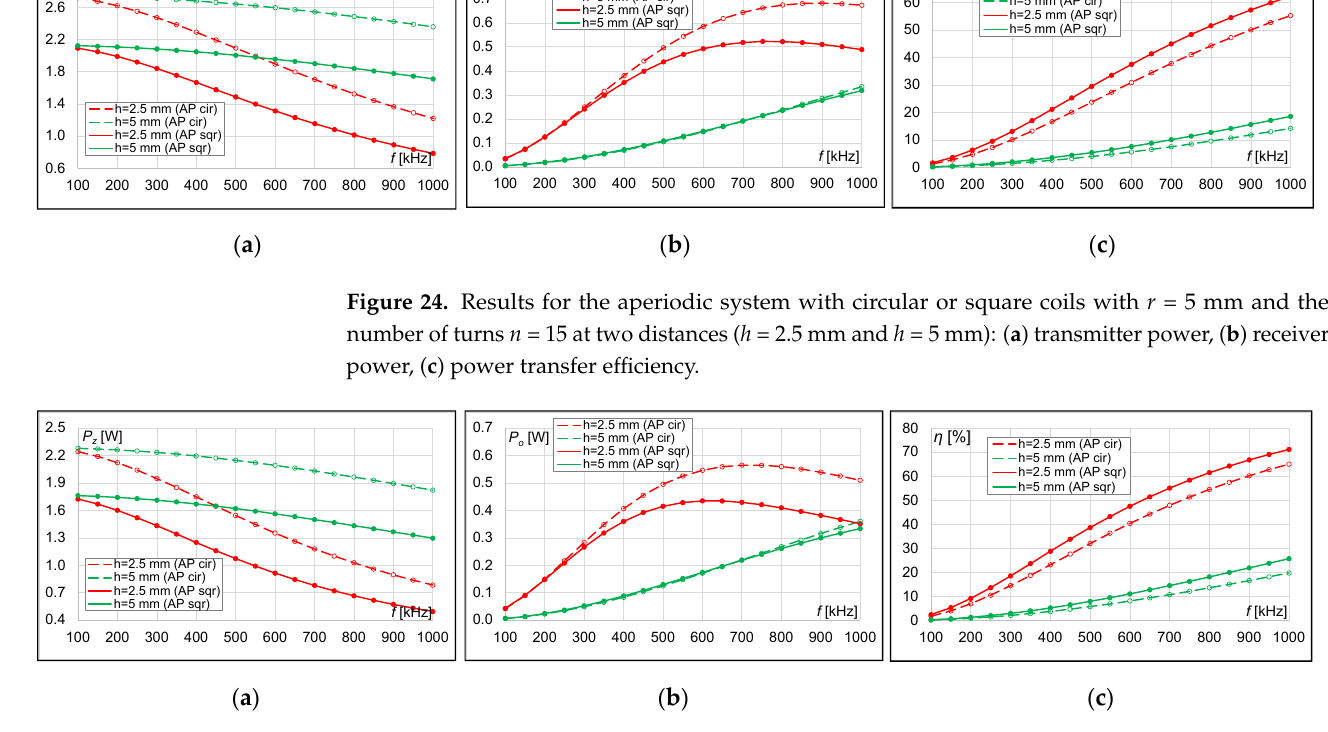
( c ) Figure 26. Results for the aperiodic system with circular or square coils with r = 5 mm and the num- ber of turns n = 25 at two distances ( h = 2.5 mm and h = 5 mm): ( a ) transmitter power, ( b ) receiver power, ( c ) power transfer efficiency. With a larger distance between the coils ( h = 5 mm), the values of the receiver power P o for circular and square coils are similar in the entire frequency range (Figures 24b, 25b, and 26b). However, for the smaller distance between the coils ( h = 2.5 mm), the power P o is higher for the circular coil. As the frequency increases, these differences become larger and larger. In contrast to periodic systems, regardless of the number of turns and frequency, the efficiency of the system is higher for models with a square coil. The highest difference in efficiency between the model with a square coil and circular coil is 7%, regardless of the distance between the coils (Figures 24c, 25c, and 26c). 3.5.2. Models with a Large Coil ( r = 20 mm) Figures 27–29 show the characteristics of power ( P z , P o ) and efficiency η at two dis- tances ( h = 10 mm, 20 mm) for aperiodic models with large circular or square coils. All characteristics depend on the number of turns and frequency. The higher transmitter power P z is in the model with a circular coil (Figures 27a, 28a, and 29a). As the frequency increases, the power P z decreases. Receiver power values P o are higher for circular coil models. At h = 10 mm, the power P o decreases with increasing frequency, regardless of the type of coil. At a distance h = 20 mm, the power P o increases until the efficiency of the system reaches 50%, and then it begins to decrease (Figures 27b, 28b, and 29b).